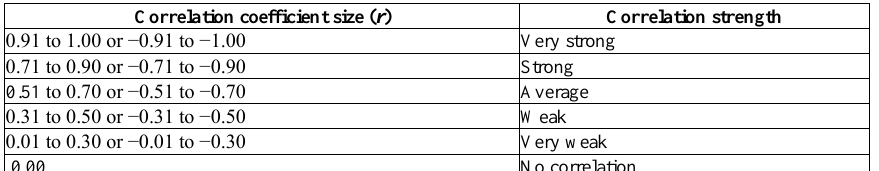
Table 3. Strengths of the Correlation Coefficient Values